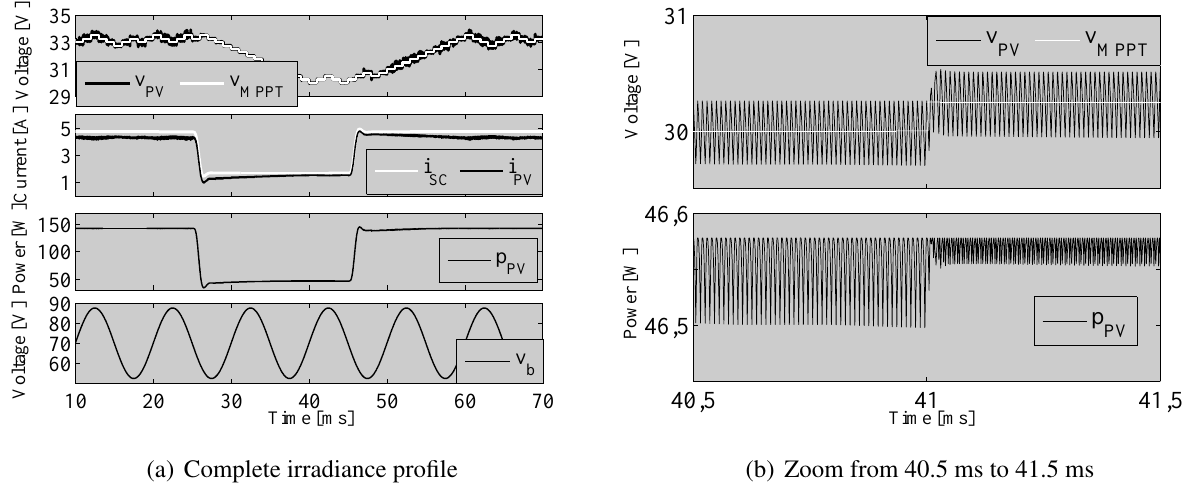
Figure 15. PV system transient response by adopting controller G